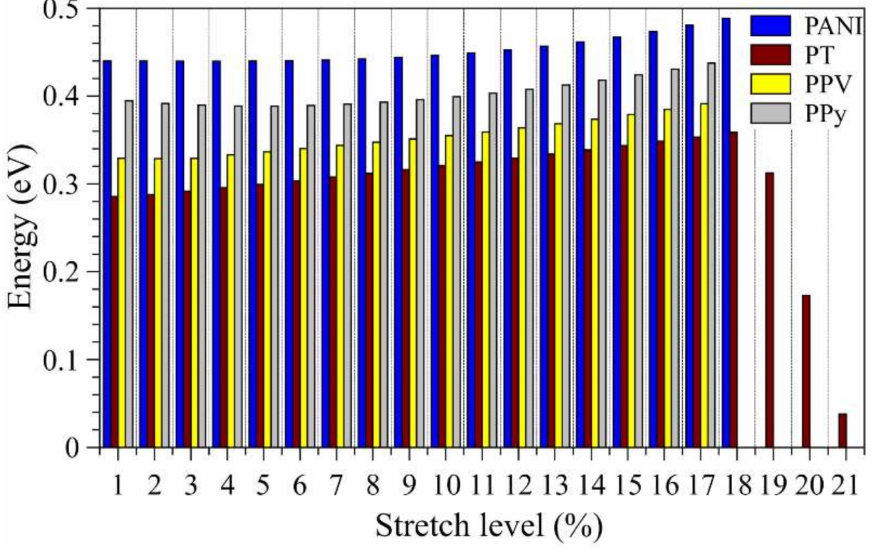
Figure 10. Evolution of the exciton binding energies during the stretching